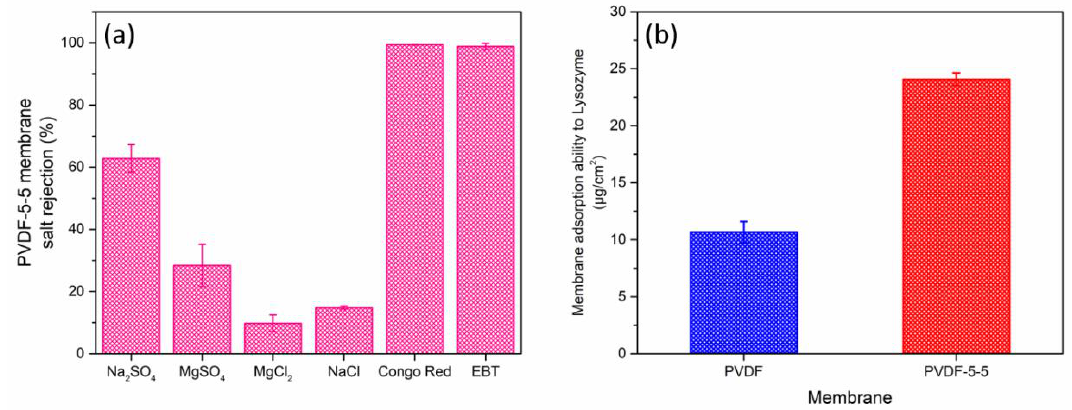
Figure 6. ( a ) Rejection properties of PVDF-5-5 membrane for 1000 mg / L of Na 2 SO 4 , MgSO 4 , MgCl 2 , NaCl solution, and 100 mg / L of Congo red (M w : 696.66) and EBT (M w : 461.38). ( b ) Static membrane adsorption ability to the positively charged model protein lysozyme.